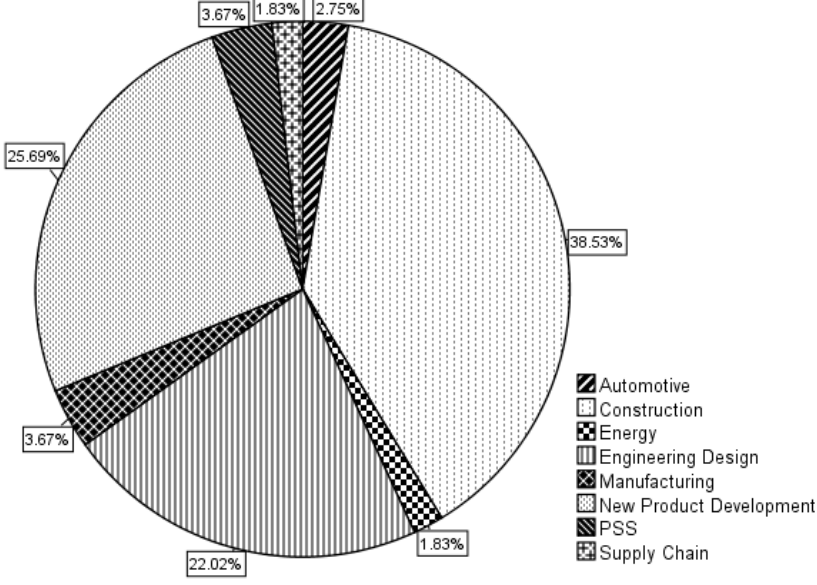
Figure 3. Distribution of review articles per sector.